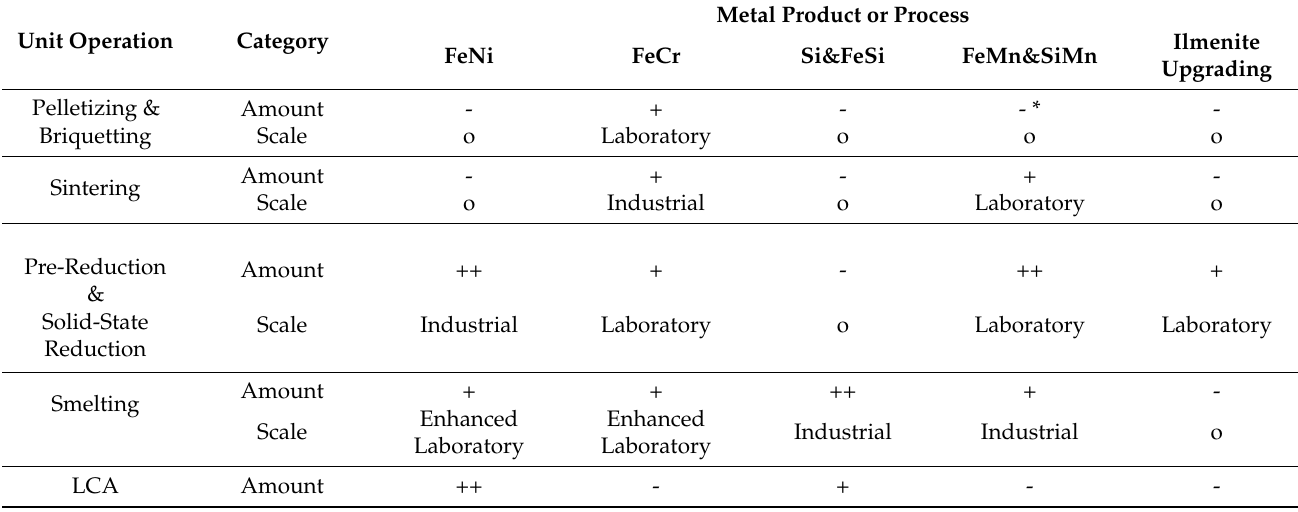
Table 7. Scale and amount of research investigating relevant unit